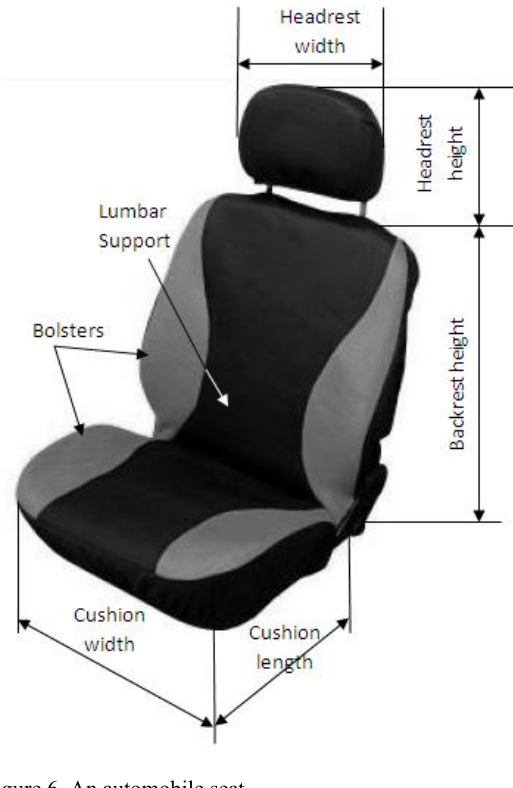
Figure 6. An automobile seat In Figure 7, the travel path of a seat is given.